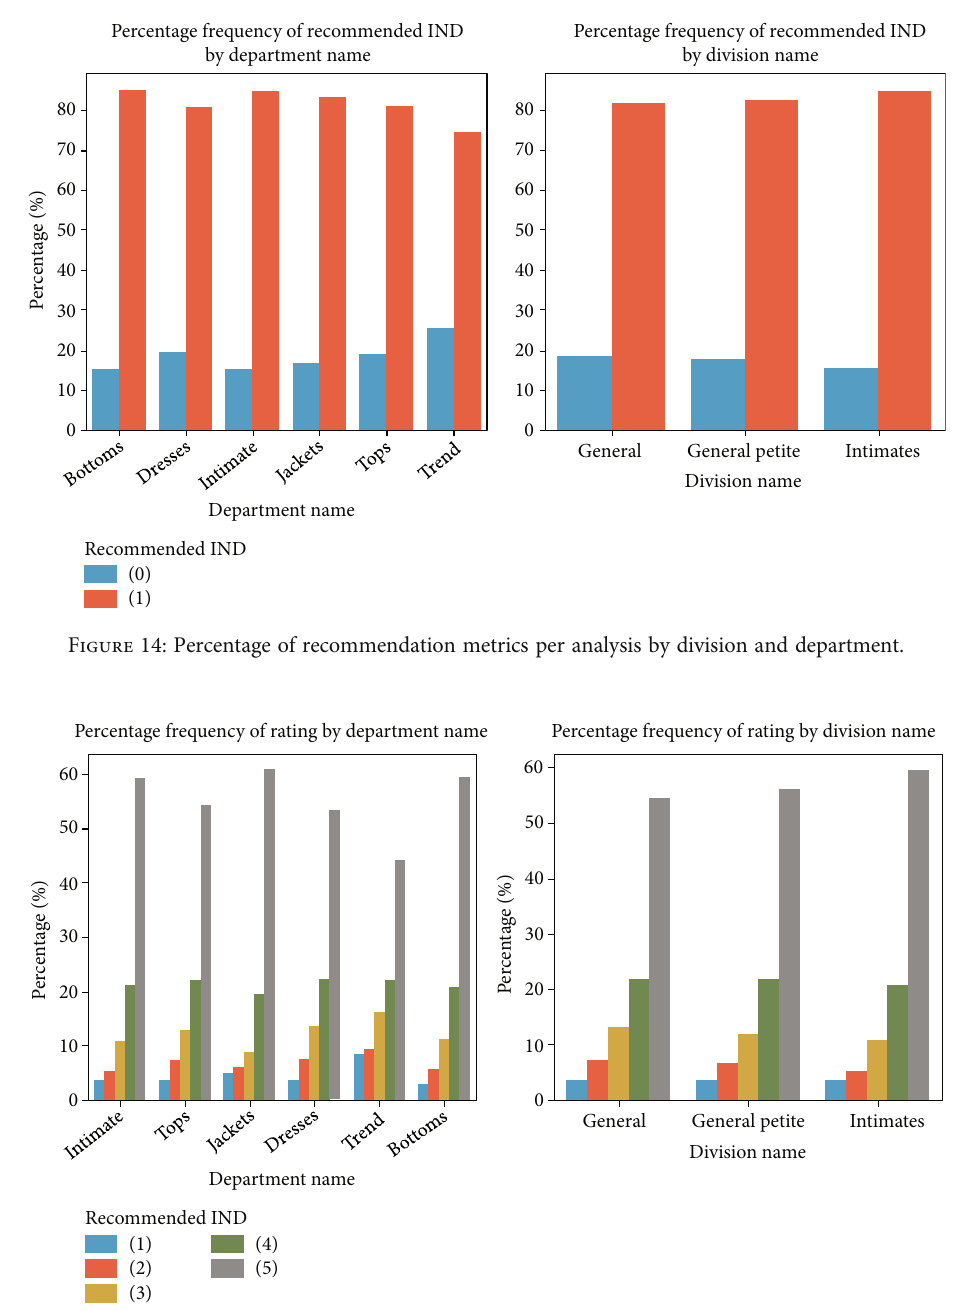
Figure 15: The continuity in the distribution of rating